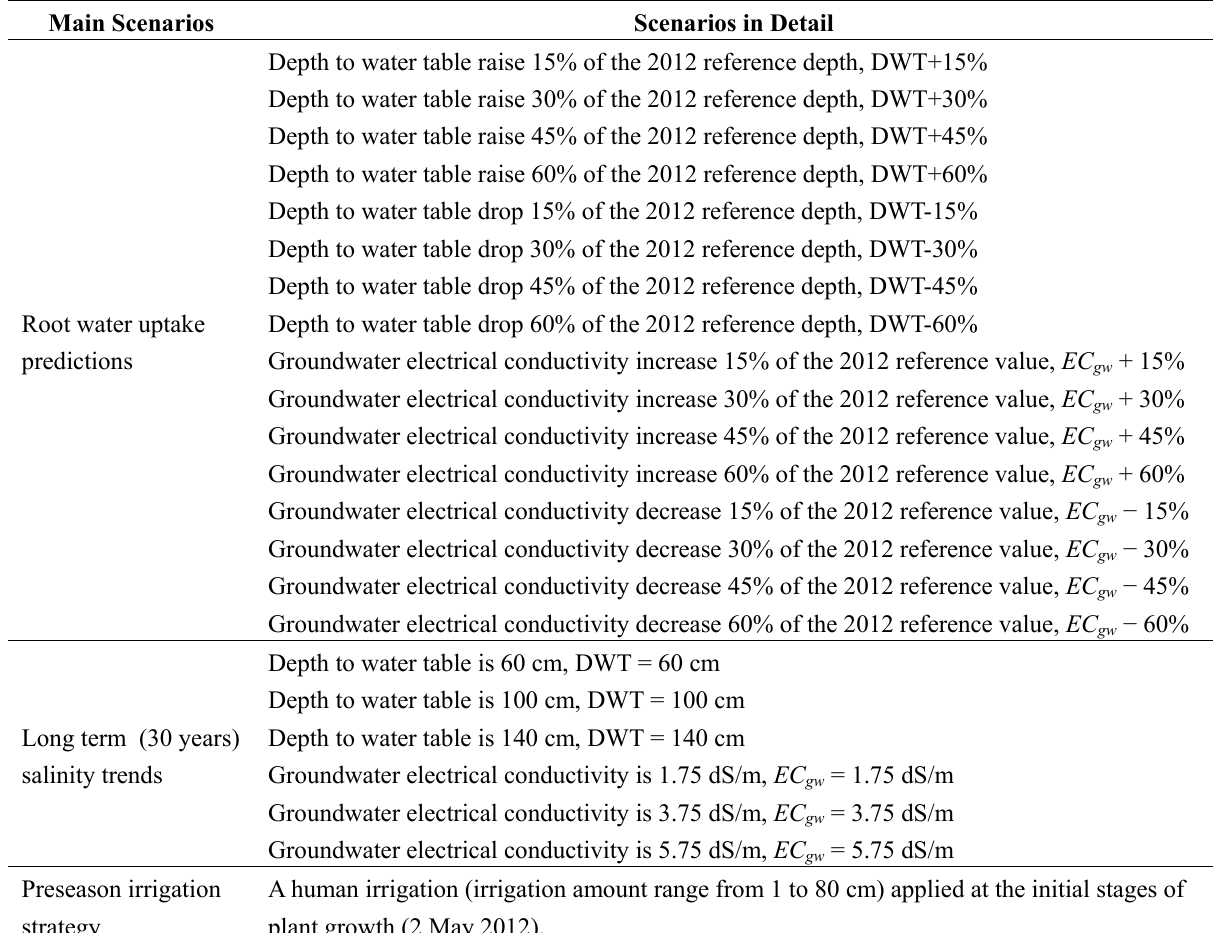
Table 2. Simulation scenarios performed in this